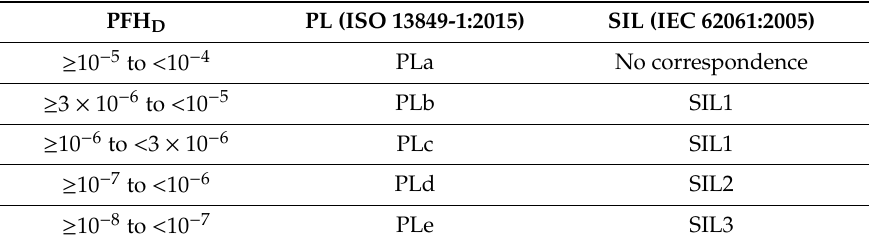
Table 1. PL and SIL compared based on their average probability of dangerous failure per hour (PFH D ). PFH